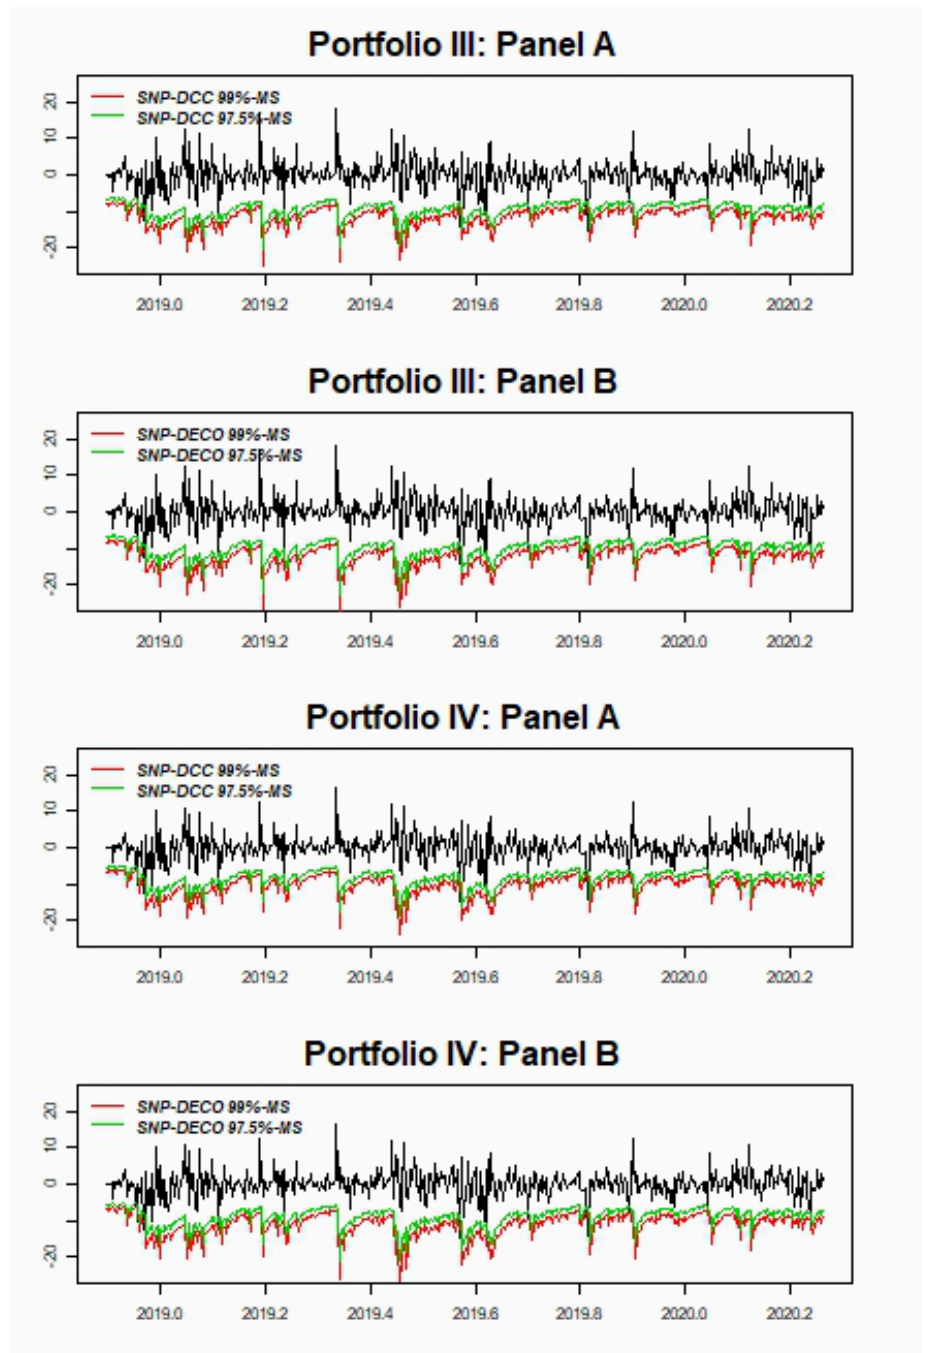
Figure 3. Portfolio returns (black line) compared to 99% median shortfall (MS) (red line) and 97.5%-MS (green line) for four portfolios with both dynamic conditional correlation (DCC) and dynamic equicorrelation (DECO). Portfolio I corresponds to equally weighted portfolio; Portfolio II is 25% Bitcoin (BTC), 25% Litecoin (LTC), and 50% Ripple (XRP); Portfolio III is a combination of 25% BTC, 50% LTC, and 25% XRP; and Portfolio IV is 50% BTC, 25% LTC, and 25% XRP. Panel A (B) displays the SNP (DECO) model for every portfolio.